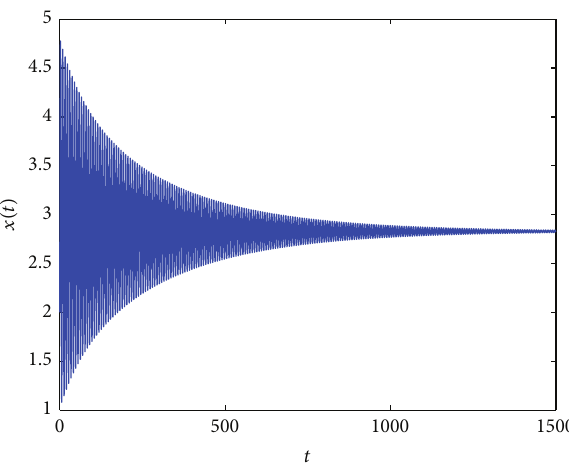
Figure 5: 𝜏 1 = 0.15 , 𝜏 2 = 0.68 , (𝑝 ∗ , 0) is asymptotically stable.